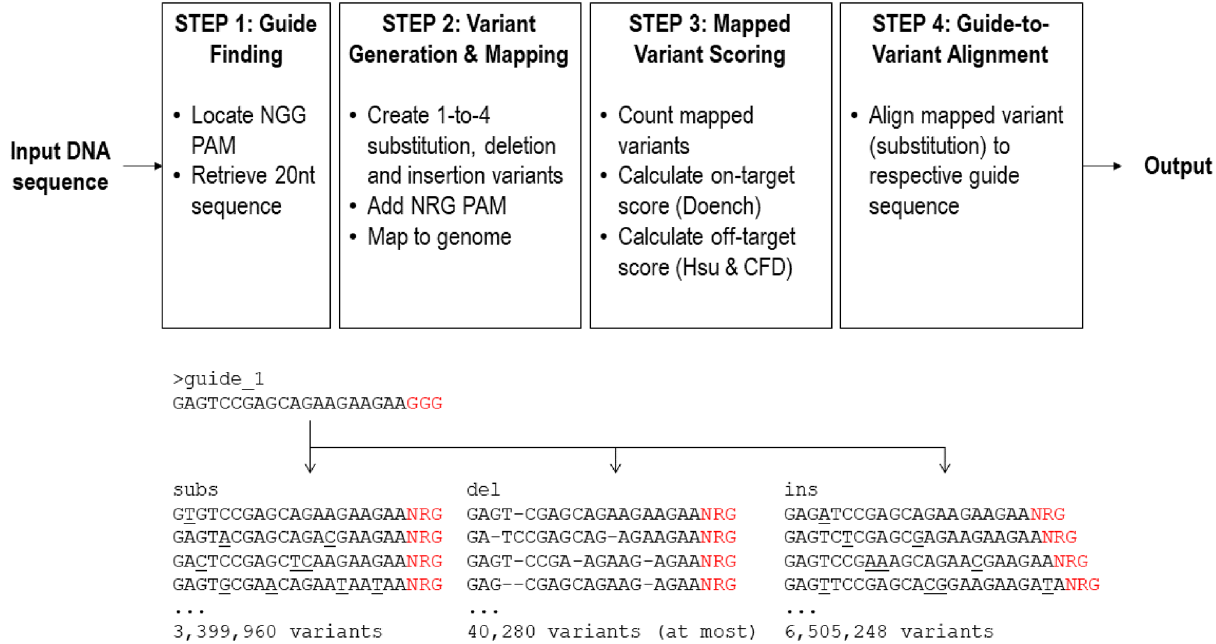
Figure 1. CROP working scheme (top) and generation of variants from a 20-nucleotide guide sequence (bottom).